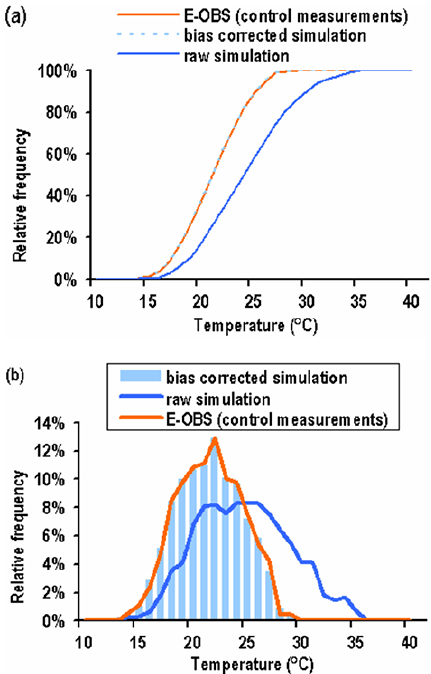
Fig. 2. Effect of bias correction on the distribution of daily mean temperature data for the grid cell representing Budapest (Hungary) in July, 1961–1990. Empirical distribution function (a) and empiri- cal density function (b) of temperature time